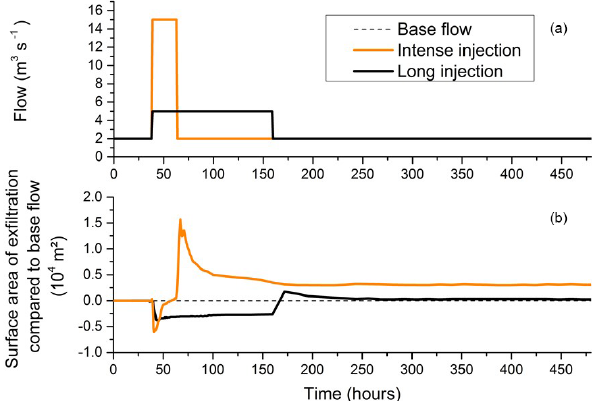
Figure 12. (a) Injection rates of two scenarios seeking optimal exfil- tration surface areas and durations at Rohrschollen Island. (b) Evo- lution over time of excess or lack of exfiltration surface area com- pared with exfiltration surface produced by a routine injection rate of 2m 3 s − 1 at the inlet of the